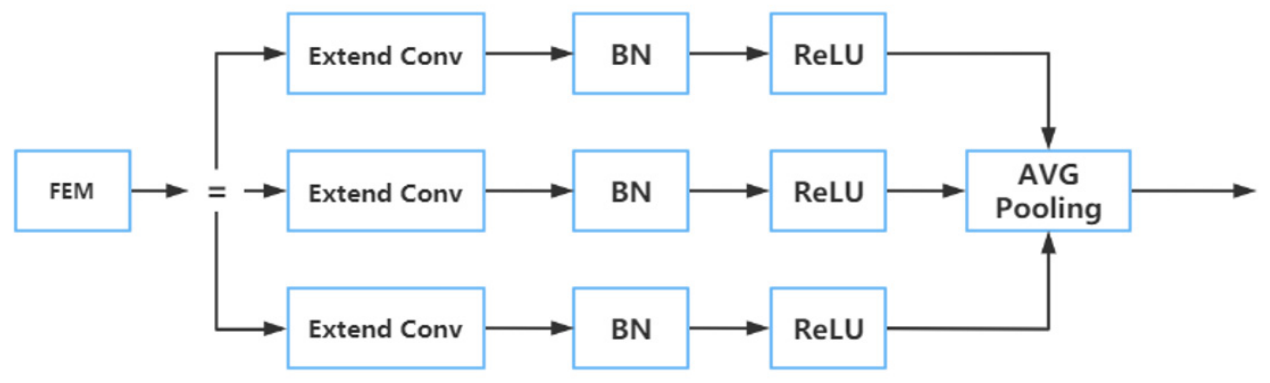
Figure 8. The structure diagram of FEM.